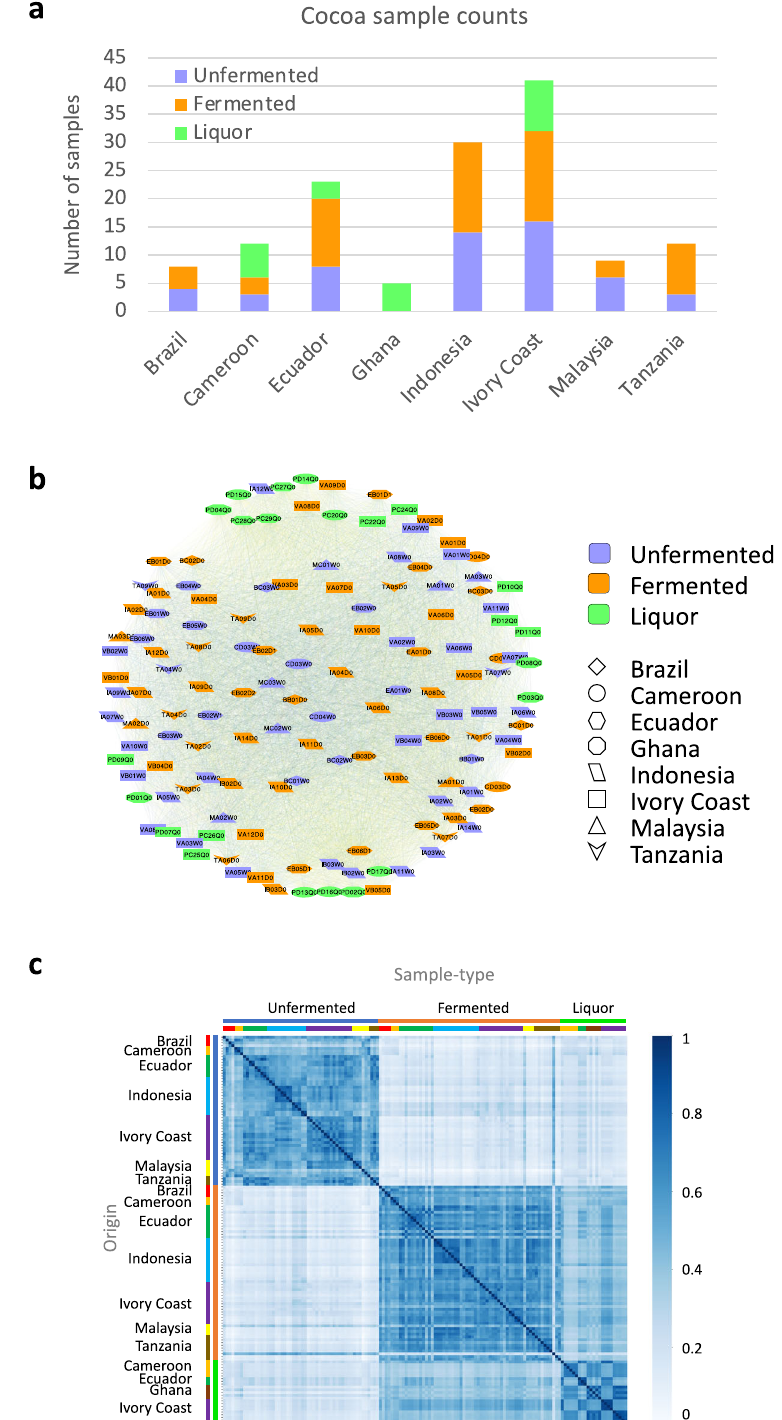
Fig. 2 Initial network details. ( a ) Distribution of Cocoa samples used in this study — a total of eight countries and three cocoa processing stages are represented. Ivory Coast contributes most samples and Ghana the least. ( b ) Correlation Network. Full correlation network made using all correlations between the set of cocoa samples using Spearman correlation (i.e., at correlation threshold of zero). The nodes are color coded according to their processing-stage sample type and shape coded by their country of origin. The network is visualized using Cytoscape 52 with ‘ edge-weighted spring embedded layout ’ which keeps nodes connected with higher correlations closer together. ( c ) Correlation Heatmap. Darker regions represent high correlation, and lighter regions represent low correlation. Samples have been sorted on twin axes, fi rst on processing stage sample-type, and then second internally on country of origin. Two distinct square block regions are clearly visible along the diagonal of the matrix, corresponding to Unfermented (smaller block) and Fermented (bigger block)